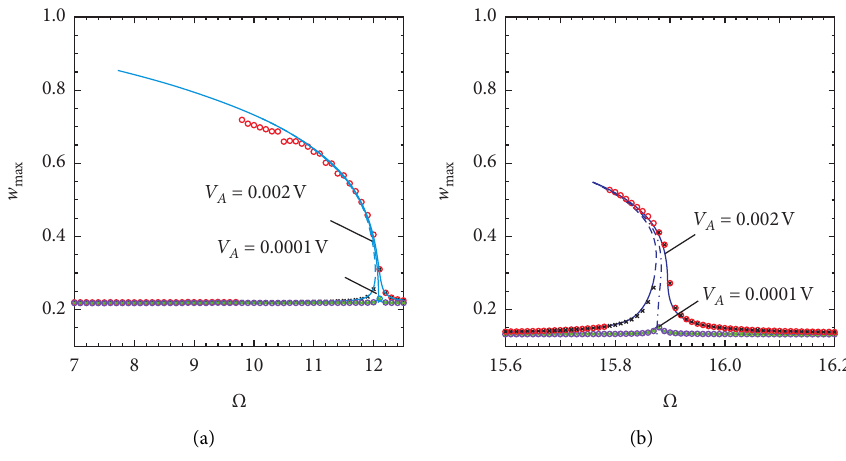
Figure 17: Amplitude-frequency curve: V